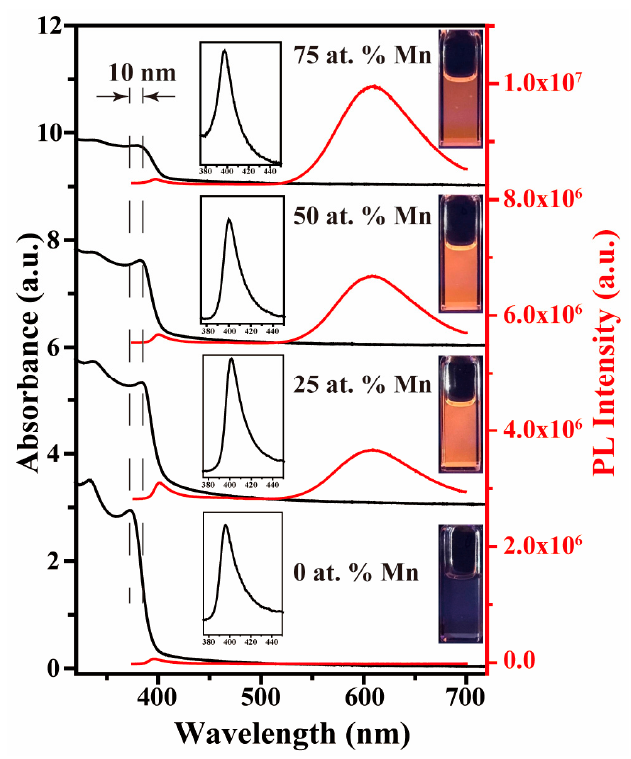
Figure 3. Absorption and PL spectra of Mn 2+ -doped CH 3 NH 3 PbCl 3 PNCs solution with different nominal Mn 2+ doping concentration. Inset: Enlarged views of PL spectra located in 375–450 nm range